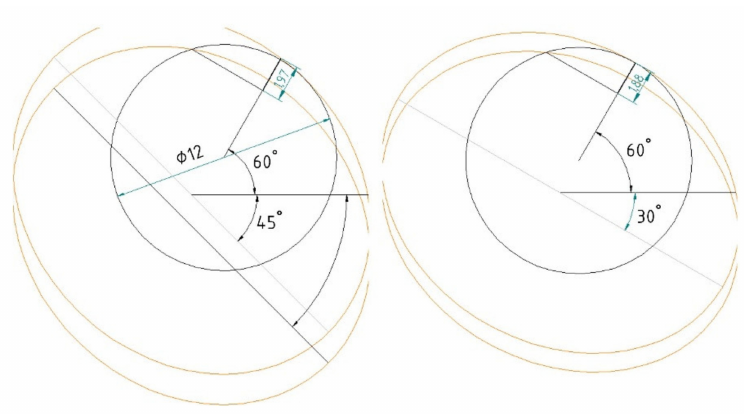
Figure 21. Graphical analysis obtaining of a eff in an elliptical trochoidal path.